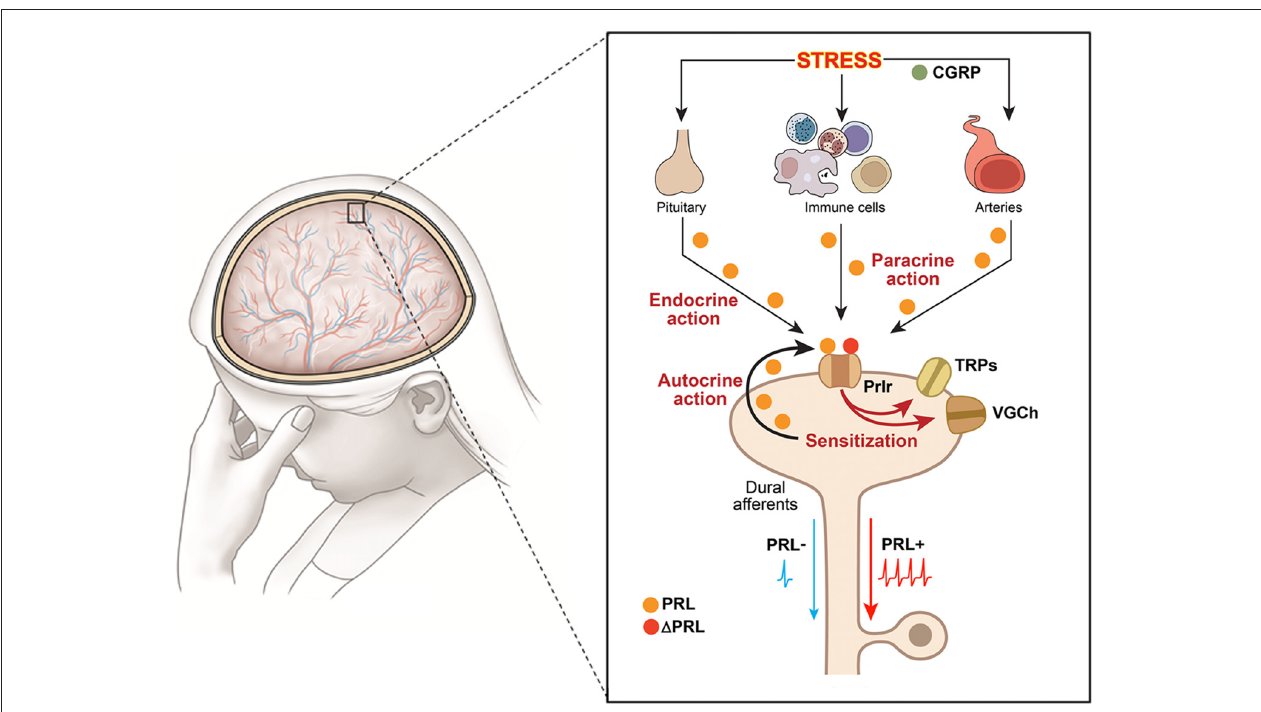
FIGURE 1 | Schematic illustration of putative mechanisms underlying hyperalgesic action of the endogenous PRL system in orofacial pain conditions. Schematic shows an orofacial pain condition, i.e., migraine, triggered by stress. The presented pathway could be suggested for other orofacial conditions triggered by inflammation or trauma. The large figure represents dura mater with nerves and vessels running throughout, and the inset shows multiple pathways for PRL release and action on sensory neurons. Dural afferents are peripheral terminals of a subset of trigeminal ganglion neurons; VGCh, voltage-gated channels; TRP, transient receptor potential; Immune cells—PRL-expressing macrophages, mast and T cells as main candidates; Prlr, prolactin receptor; ∆ PRL, Prlr antagonist, which is modified PRL that binds but does not activate Prlr; CGRP, calcitonin gene related peptide; PRL − , dural afferents without PRL stimulation; PRL+, dural afferents stimulated with